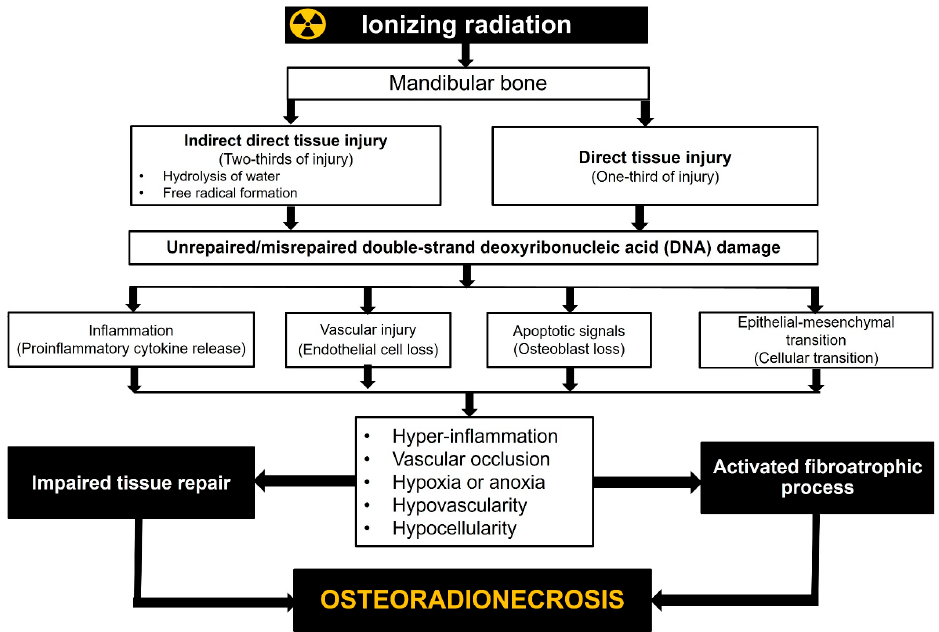
Figure 1. Radiobiological mechanisms of jaw osteoradionecrosis.